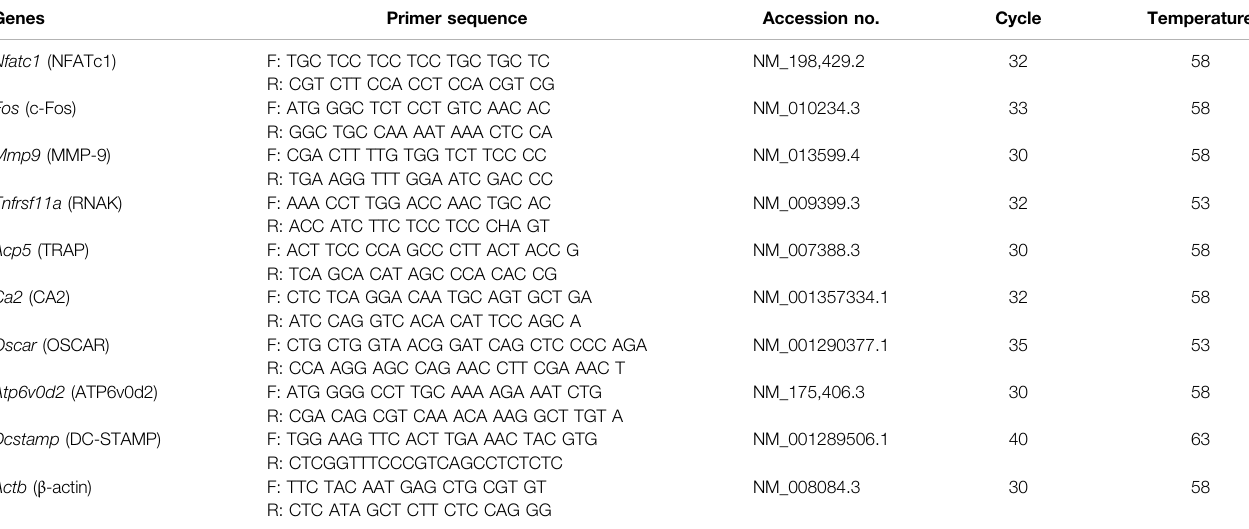
TABLE 1 | Primer sequences for RT – PCR